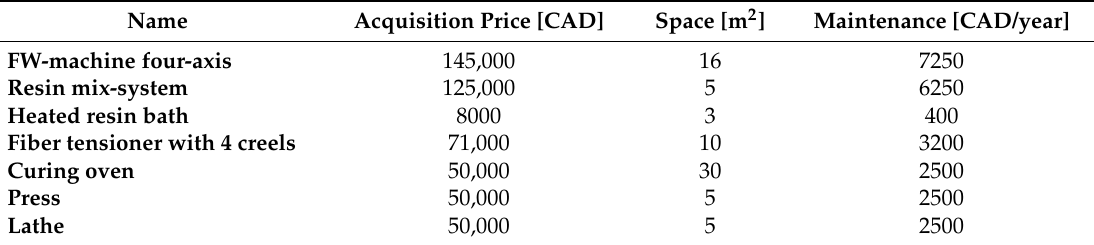
Table 1. Prices, space and maintenance costs of manufacturing machines (based on [21]).